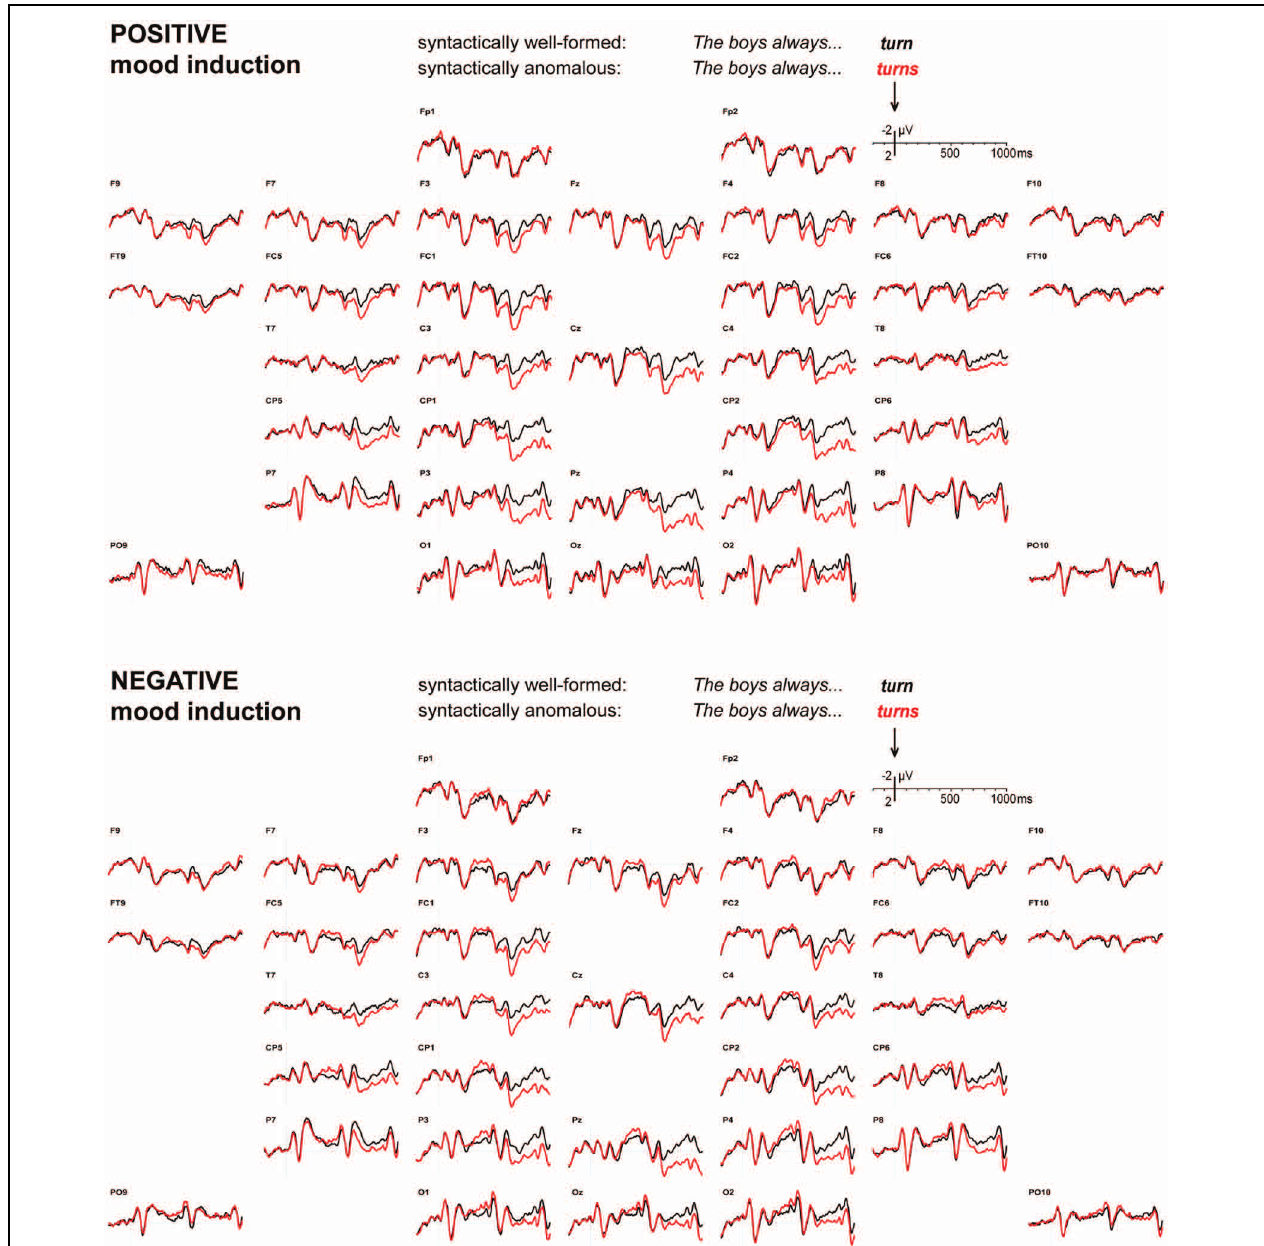
FIGURE 2 | Syntax. ERPs to syntactically well-formed (black) or anomalous (red) verbs, after positive (top) or negative (bottom) mood induction. Onset of the verb at 0ms, other graphics details as in Figure 1 .